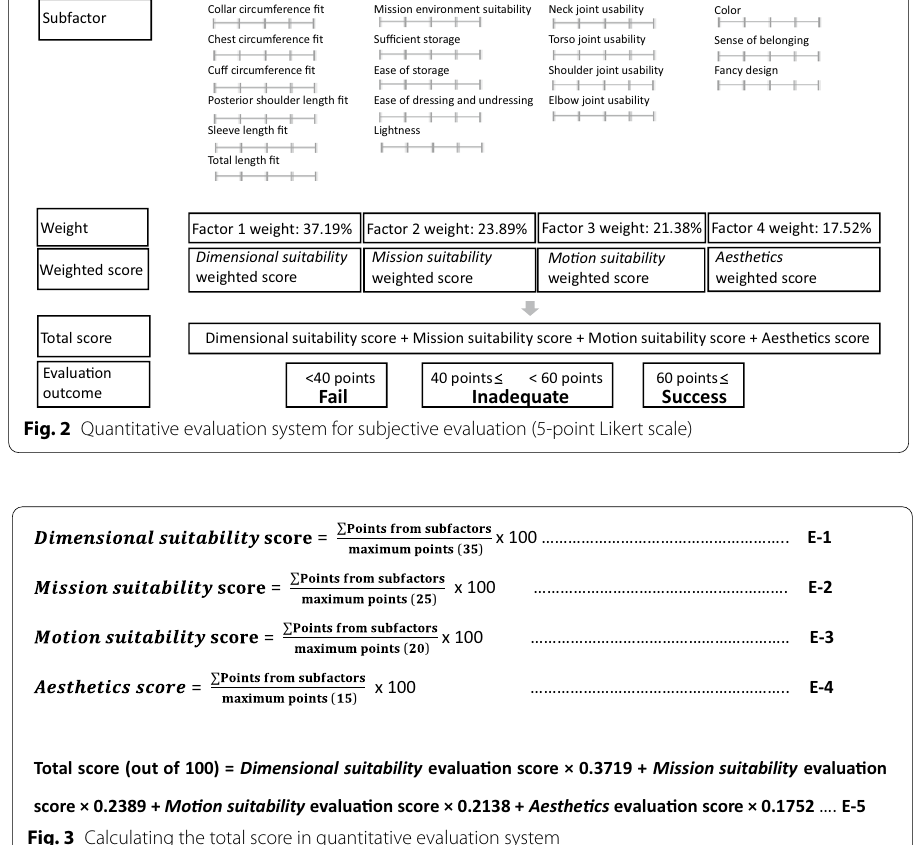
Fig. 3 Calculating the total score in quantitative evaluation